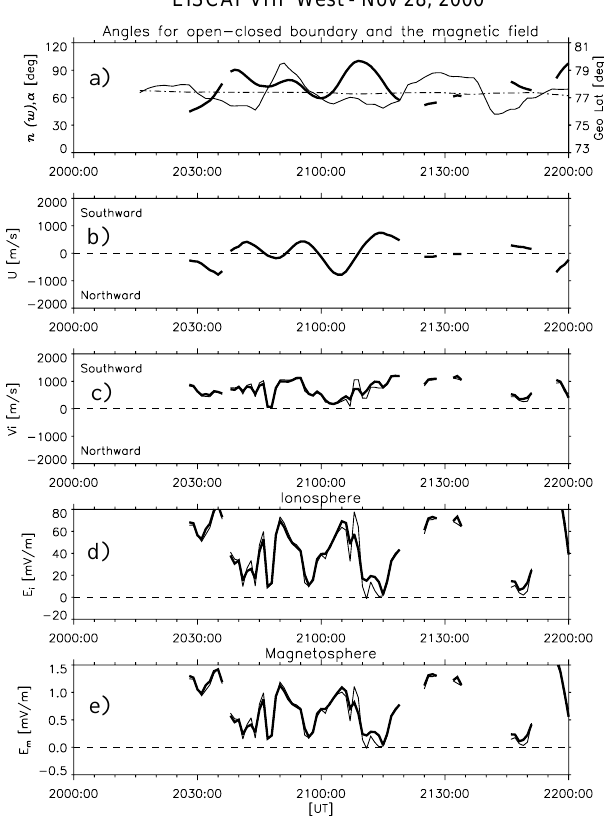
Fig. 7. Same as Fig. 6, but for the west